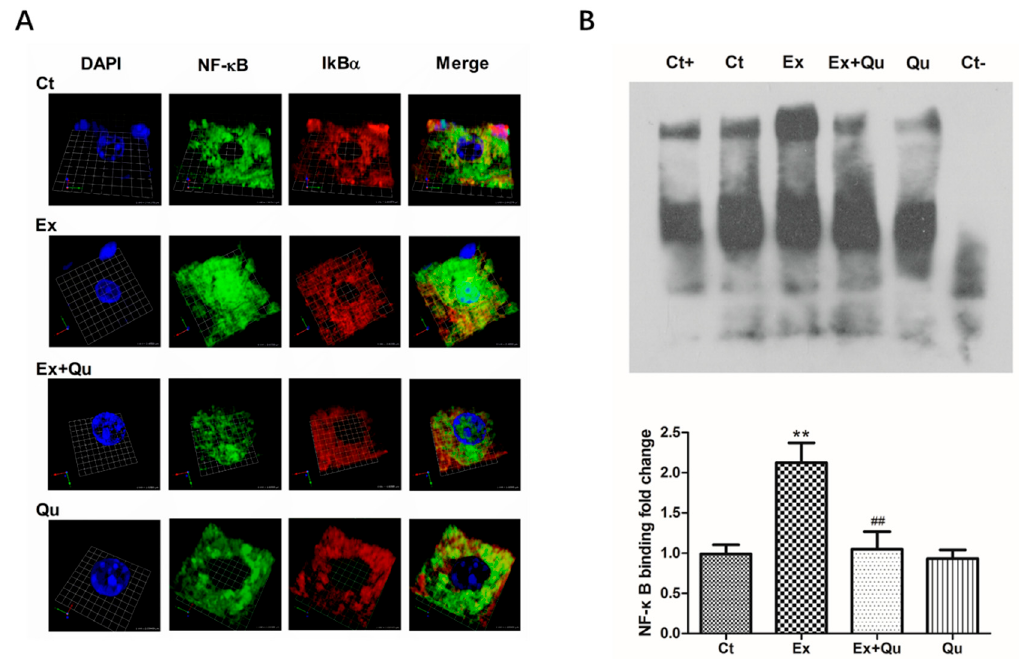
Figure 6. E ff ect of quercetin on the nuclear expression level and activity of NF- κ B in mice liver following intensive running. ( A ) Liver sections were probed with NF- κ B (green) and I κ b α (red) antibodies, while DAPI was used to stain the nuclei (blue); ( B ) activity of NF- κ B-DNA binding was quantified by densitometry. Specific binding was verified by the addition of unlabeled (cold) oligonucleotide (competitor, Ct-) or labeled oligonucleotide mutate (noncompetitor, Ct + ). Representative EMSA (upper panel) and densitometric analysis (lower panel). Data presented as fold-change in contrast to the control group. Values presented as mean ± SD ( n = 8). Ct—rested control; Ex—intensive exercise; Ex + Qu—Ex + quercetin; Qu—rested + quercetin. ** p < 0.01 vs. Ct; ## p < 0.01 vs. Ex.